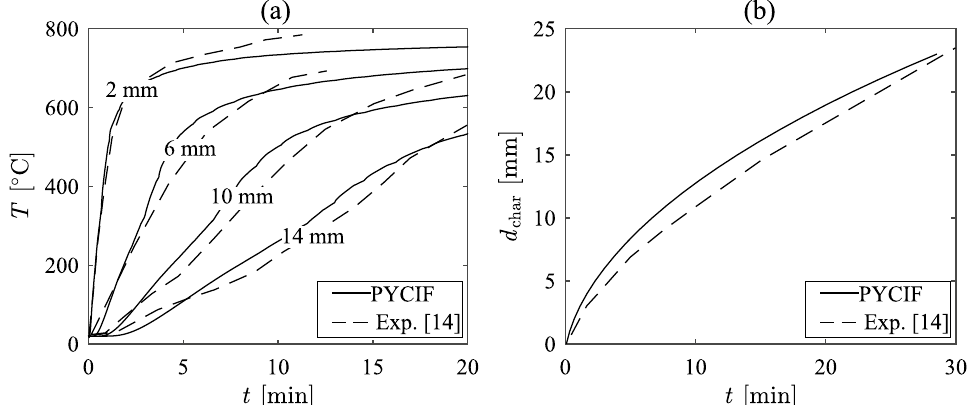
Fig. 9 Comparison of experimental and numerical results for 60 kW/m 2 cone calorimeter test. a The development of temperatures in different points of the specimen. b The development of charring